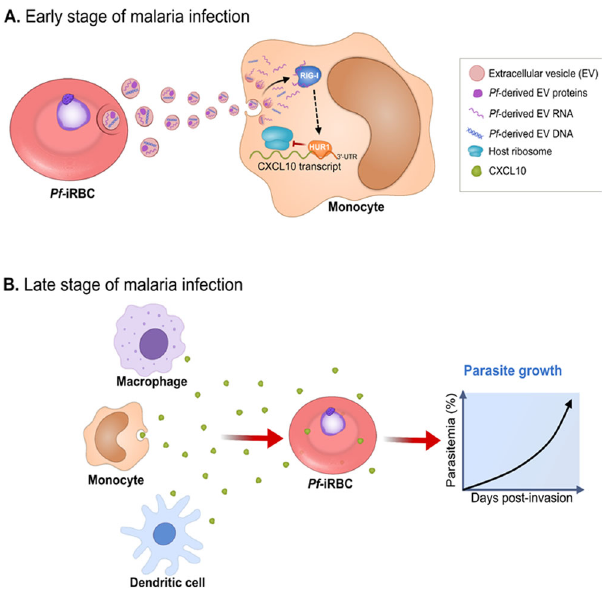
Fig. 6 proposed two-phase mechanism of CXCL10 regulation. A ‘ decision sensing system ’ : A In non-complicated malaria (upper panel) the Pf -iRBCs repress CXCL10 expression in host monocytes via transferring of RNA cargo encapsulated in parasite-derived EVs. The RNA cargo is then recognized by the host RNA receptor, RIG-I, leading to a cascade of events that eventually blocks the association of the ribosomes to CXCL10 transcript in a process mediated by its 3 ′ UTR and binding of HUR1. B However, in complicated malaria (such as CM) when CXCL10 level are higher, the chemokine is sensed back as an ‘ alert facilitator ’ , prompting parasitic proliferation, possibly allowing an escape action (bottom panel). Other host immune cells produce and secrete